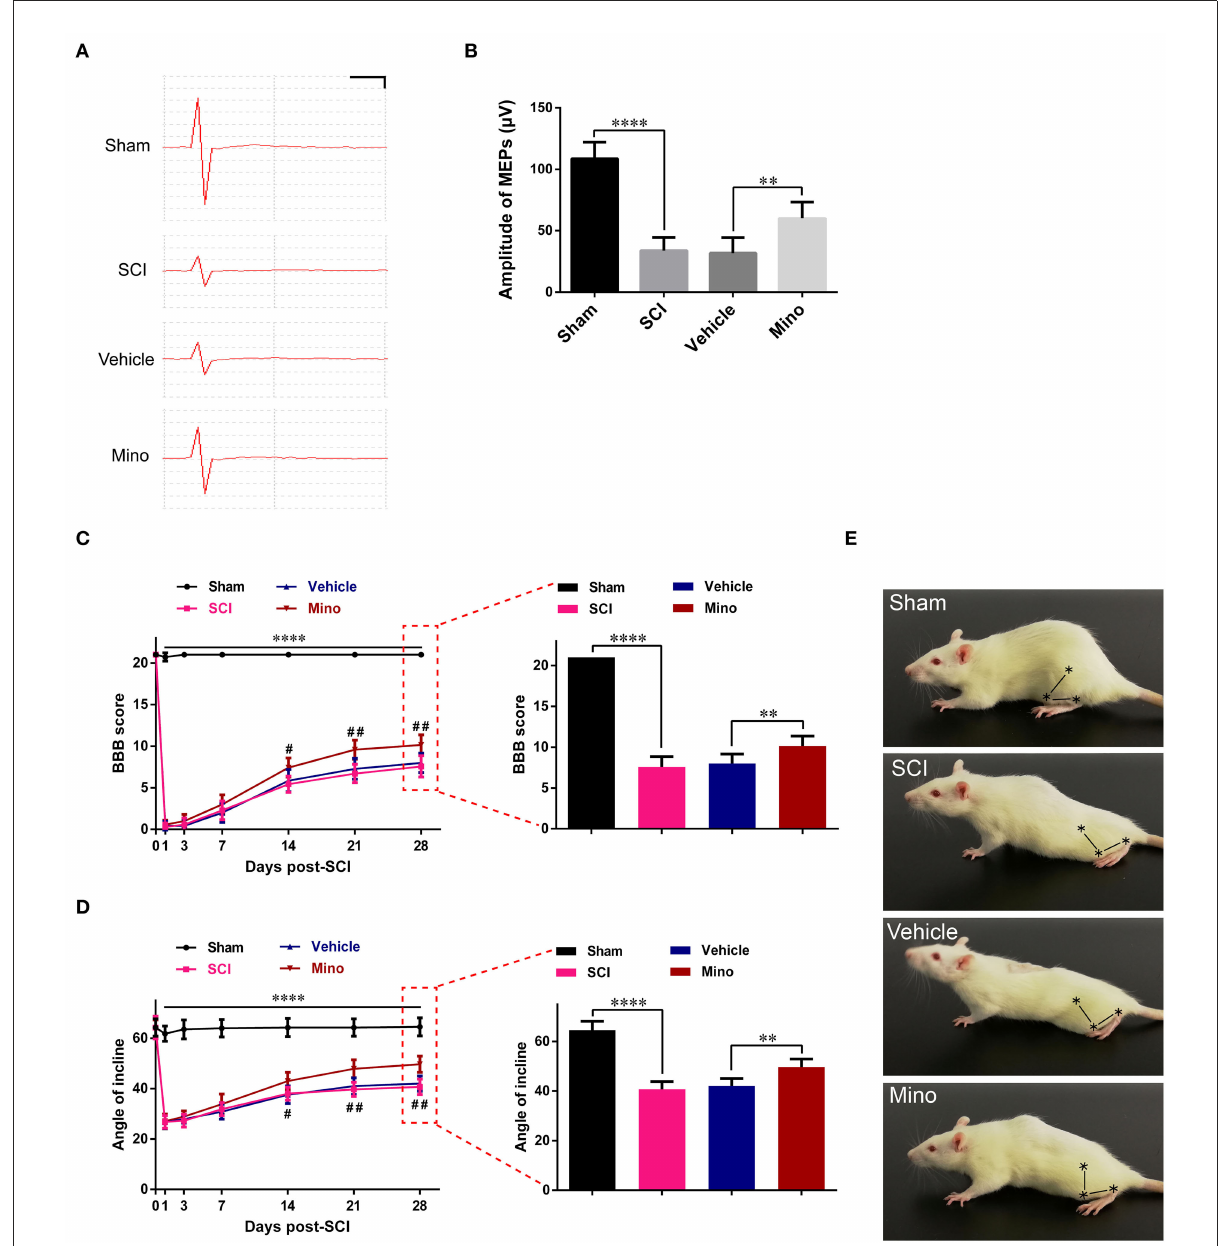
FIGURE4 Suppressing neuroinflammation in M1 improved the integrity of the motor pathway and enhanced locomotor recovery after SCI. (A) Representative motor-evoked potentials (MEPs) and (B) quantitative analysis of the amplitudes of MEPs of each group (scale: 25 µ V/1ms). (C) The BBB scores and (D) angles of inclination of each group at different time points. (E) Representative motor function for each group. The symbols represent the hip, knee, and ankle joints (data were presented as means ± SD, n ≥ 6; **** p < 0.0001 Sham group vs. SCI group, # p < 0.05, ## p < 0.01 Vehicle group vs. Mino group, for left panels; ** p < 0.01, **** p <